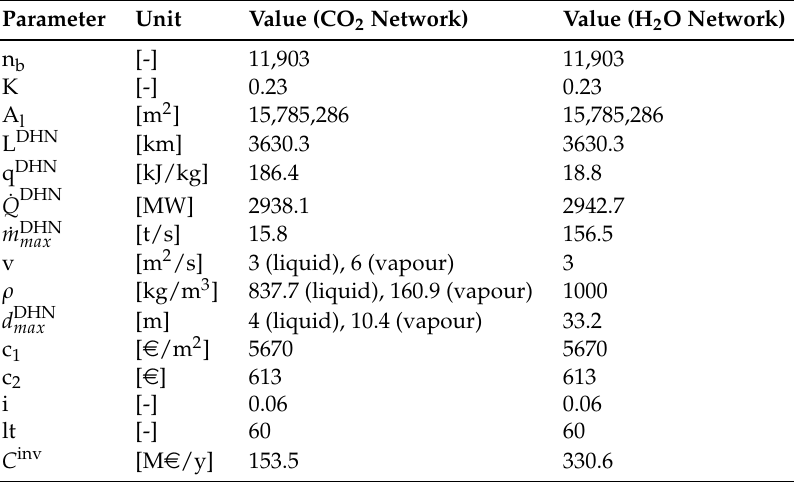
Table A17. Network cost